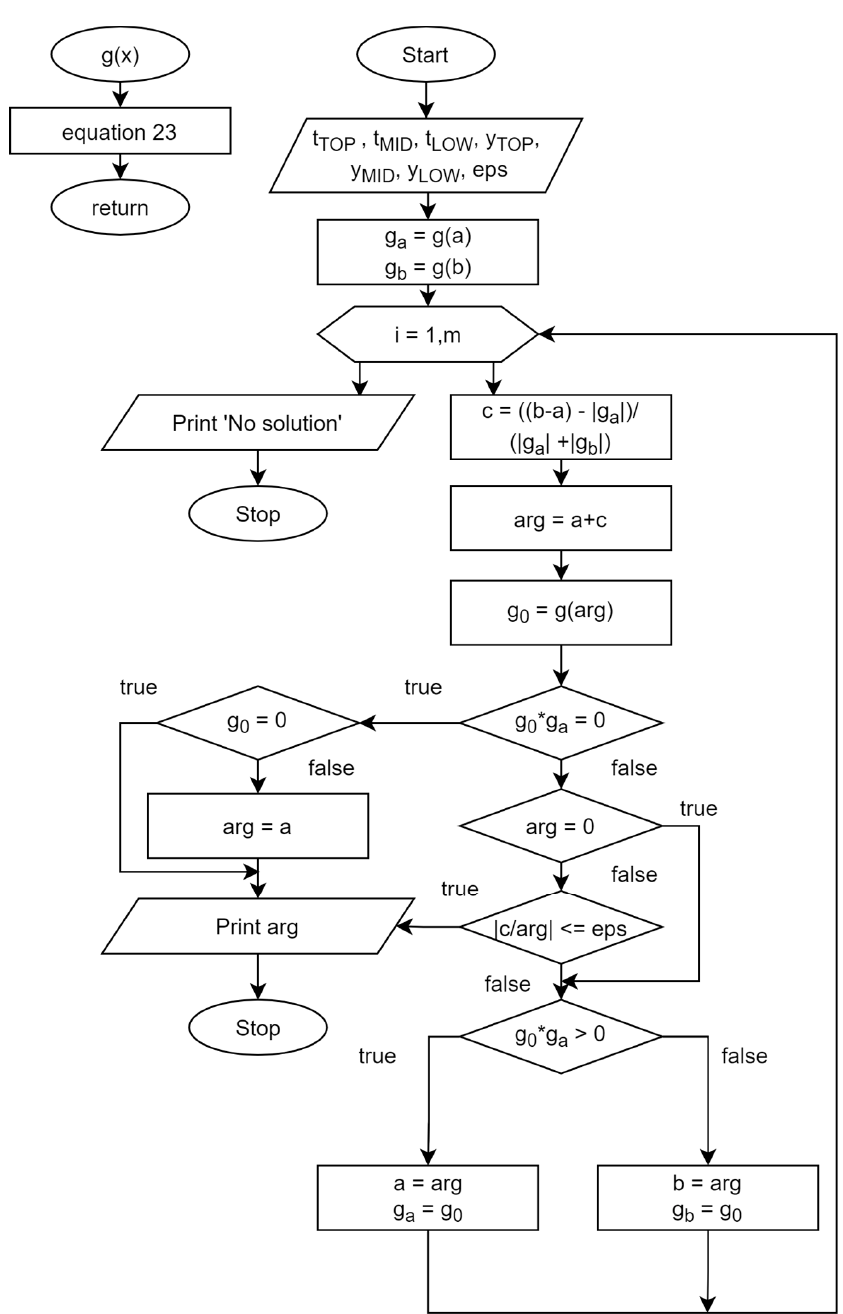
Figure 4. Block diagram for the calculation of the root of the g(x) function being in the range [a, b] by means of the secant method.